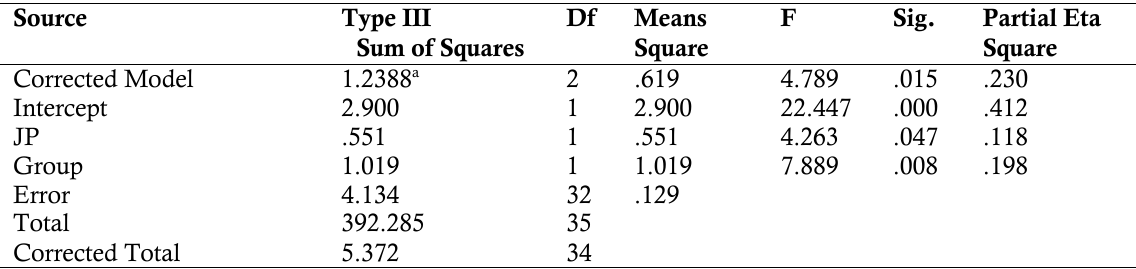
Table 1: Summary of ANCOV A on the perceived impact of mentoring programme on job performance